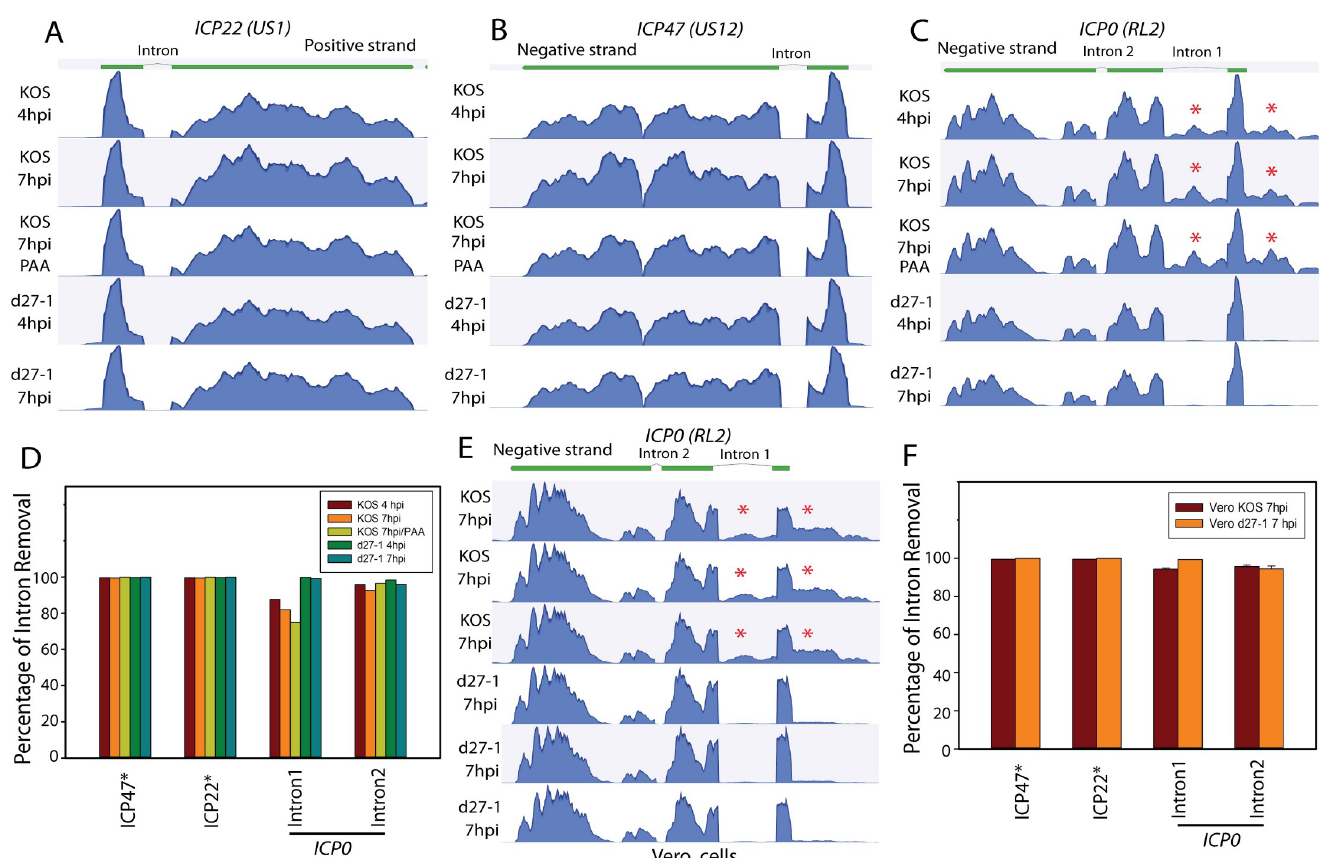
Fig 3. ICP27 does not appear to influence pre-mRNA splicing of IE genes. RNA-seq data from wildtype HSV or ICP27 deletion mutant infected HEK-293 cells were aligned to the HSV-1 genome using CLC Genomics Workbench. Previously described non ICP27-dependent transcript isoforms (thick green lines above the graphs denote exons) are shown on top of the graph. Pre-mRNA splicing of ( A ) ICP22 (positive strand), ( B ) ICP47 (negative strand), and ( C ) ICP0 (negative strand) was efficient in both KOS and d27-1 infected cells. Apparent retention of ICP0 intron 1 in KOS-infected cells was accompanied by increased reads mapping upstream of the ICP0 transcription initiation site. � indicates difference in read count mapping to ICP0 intron 1 and sequences upstream of the ICP0 transcription initiation site between KOS and d27-1 infected cells. ( D ) Impact of ICP27 on splicing efficiency of the spliced IE transcripts in infected HEK-293 cells was quantitatively analyzed by mapping the high throughput sequencing data to reference sequences including exon-exon junction and exon-intron junction sequences. ( E ) RNA-seq data from wildtype HSV or ICP27 deletion mutant infected Vero cells were analyzed for the ICP0 locus. � indicates difference in read count mapped to ICP0 intron 1 and sequences upstream of the ICP0 transcription initiation site between KOS and d27-1 infected cells. ( F ) Mean (and standard deviation) percentage of intron removal showing ICP27 impact on splicing efficiency of the spliced IE transcripts in infected Vero cells. based on the. Slightly less severe intron retention for ICP0 intron 2 was observed in KOS infected Vero cells vs. HEK-293 cells.